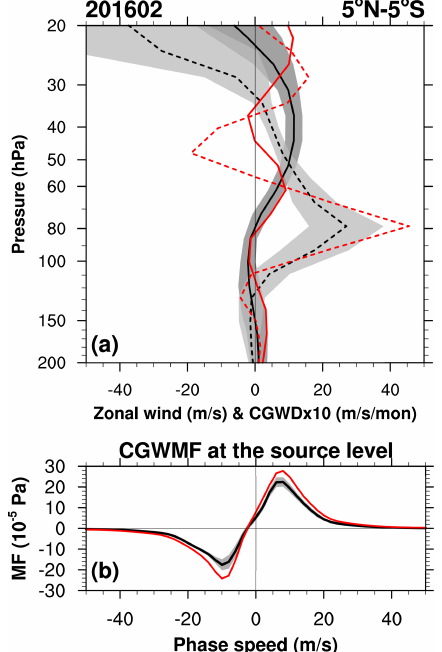
Figure 14. (a) The zonal-mean zonal wind profile and the zonal mean CGWD profile averaged over 5 ◦ N–5 ◦ S in February 2016 (red solid and red dashed, respectively) and those for the climatol- ogy (black solid and black dashed, respectively) with ± 1SD (dark gray and light gray shading, respectively). (b) Phase-speed spectra of the zonal-mean zonal CGW momentum flux at the source level averaged over 5 ◦ N–5 ◦ S in February 2016 (red) and the climatol- ogy (black) with ± 1SD (gray